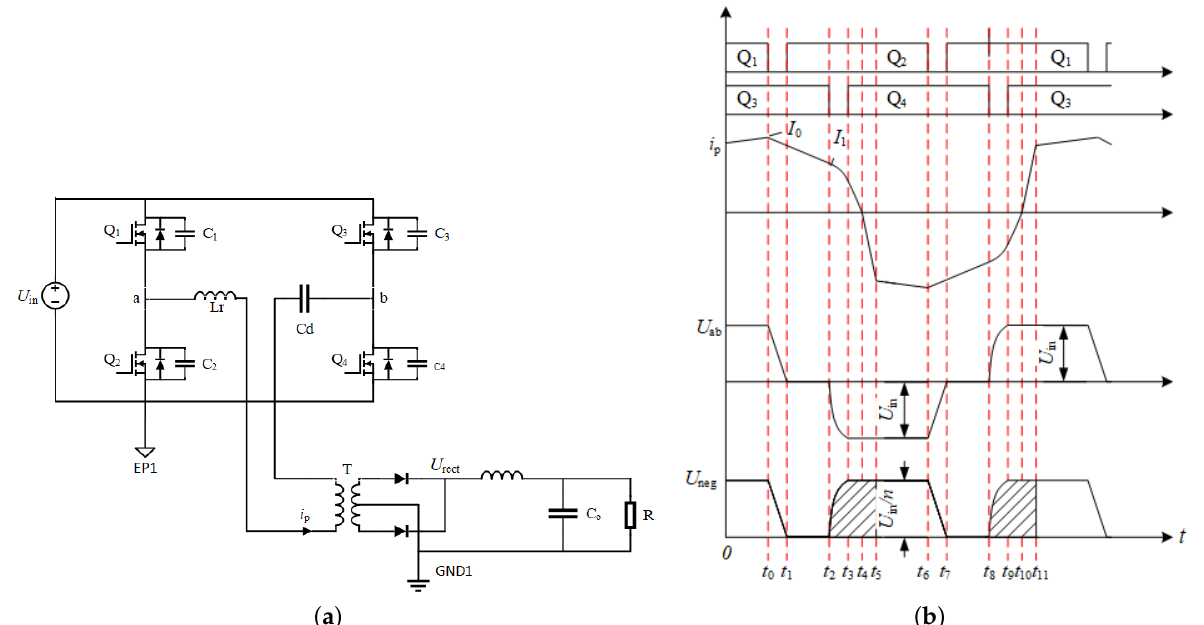
Figure 5. Circuit of the phase-shifted full bridge. ( a ) Circuit of PSFB; ( b ) the 12 operating modes of PSFB.